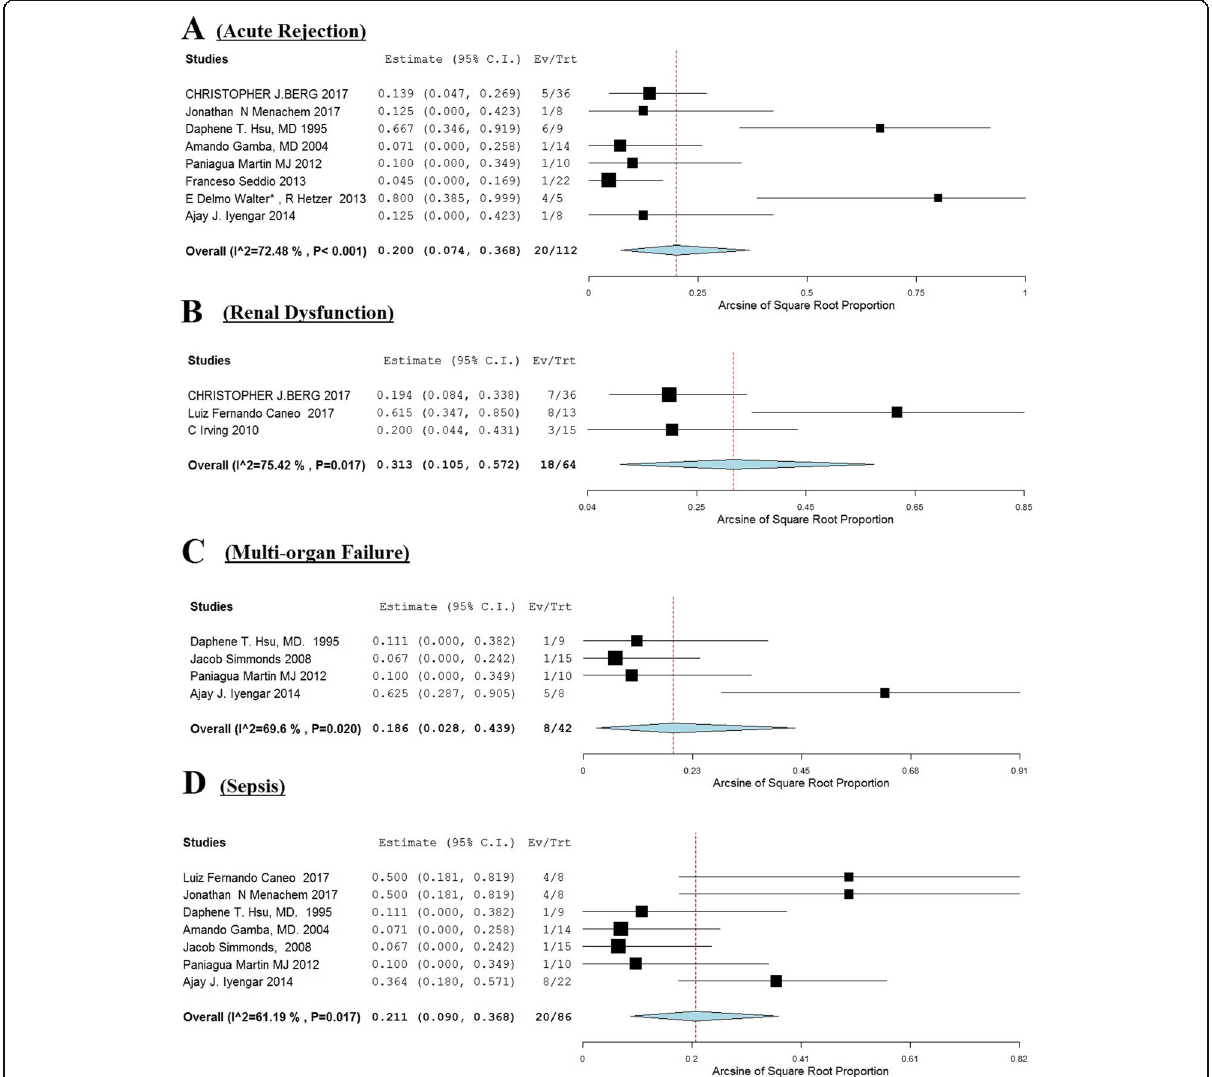
Fig. 3 Forest plots for safety outcomes: a acute rejection, b renal dysfunction, c multi-organ failure, and d sepsis. I^2, heterogeneity; 95% CI, 95% confidence interval; Evt/Trt,